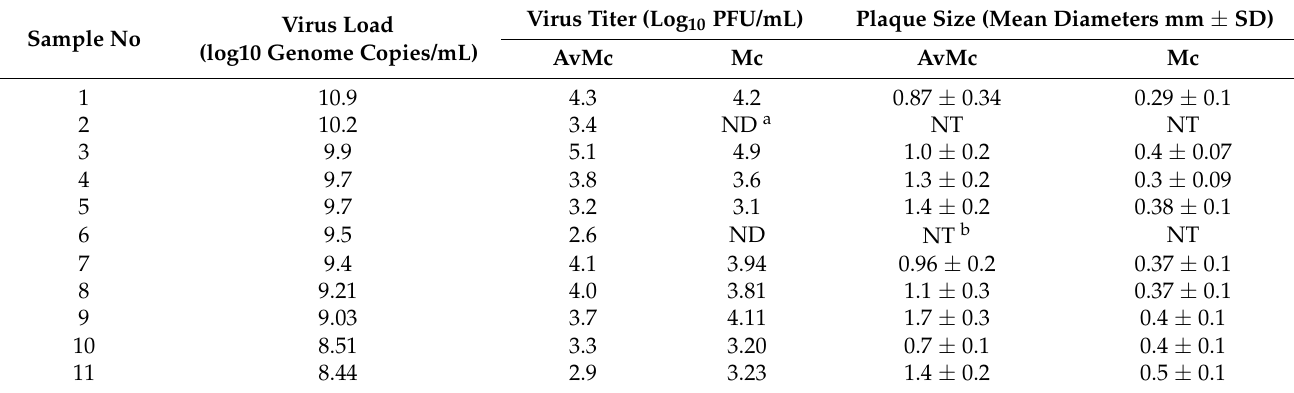
Table 5. Virus titers and average plaque size (mm) in COVID-19 patients as determined by using a conventional plaque assay with Avicel and methylcellulose overlay